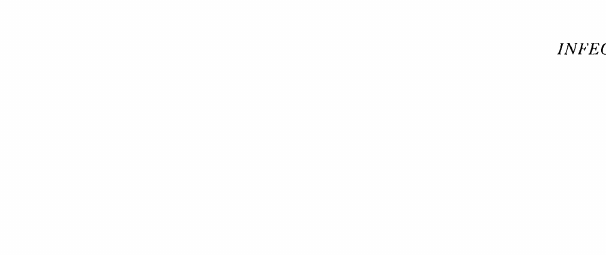
1989. TABLE 2. Risk factors in the development of CDAC